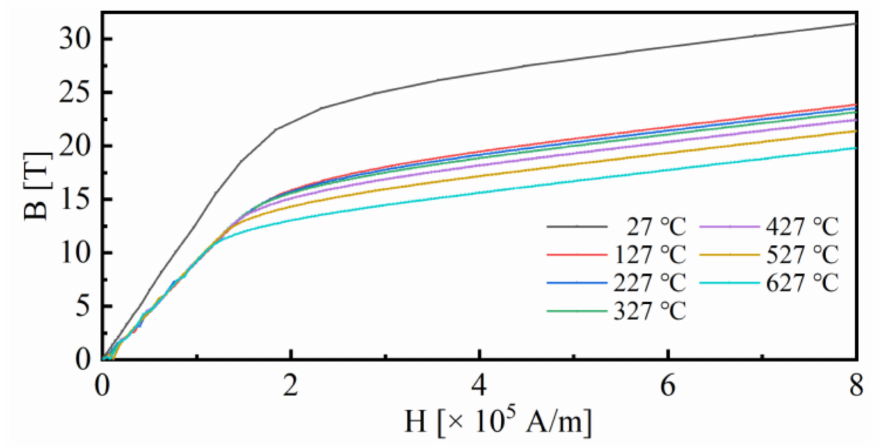
Figure 3. Magnetization curves of B1500HS steel at different